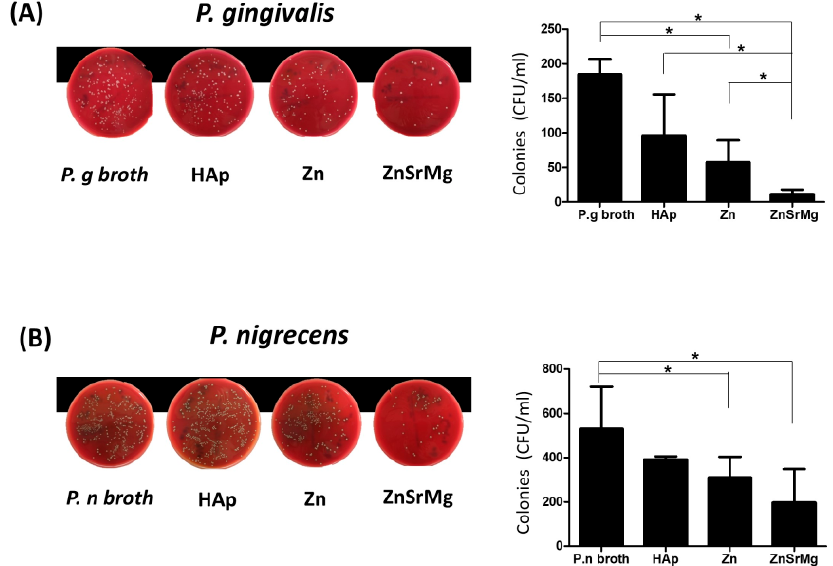
Figure 3. Antibacterial activity against P. gingivalis and P. nigrescens in the HAp, Zn-HAp, and ZnSrMg-HAp groups. ( A ) The growth of a P. gingivalis colony on Brucella blood agar plates (left). The quantification of P. gingivalis is shown as CFU/mL (right). ( B ) The growth of a P. nigrescens colony on Brucella blood agar plates (left). The quantification of P. nigrescens is shown as CFU/mL (right). CFU: colony forming unit, * p <